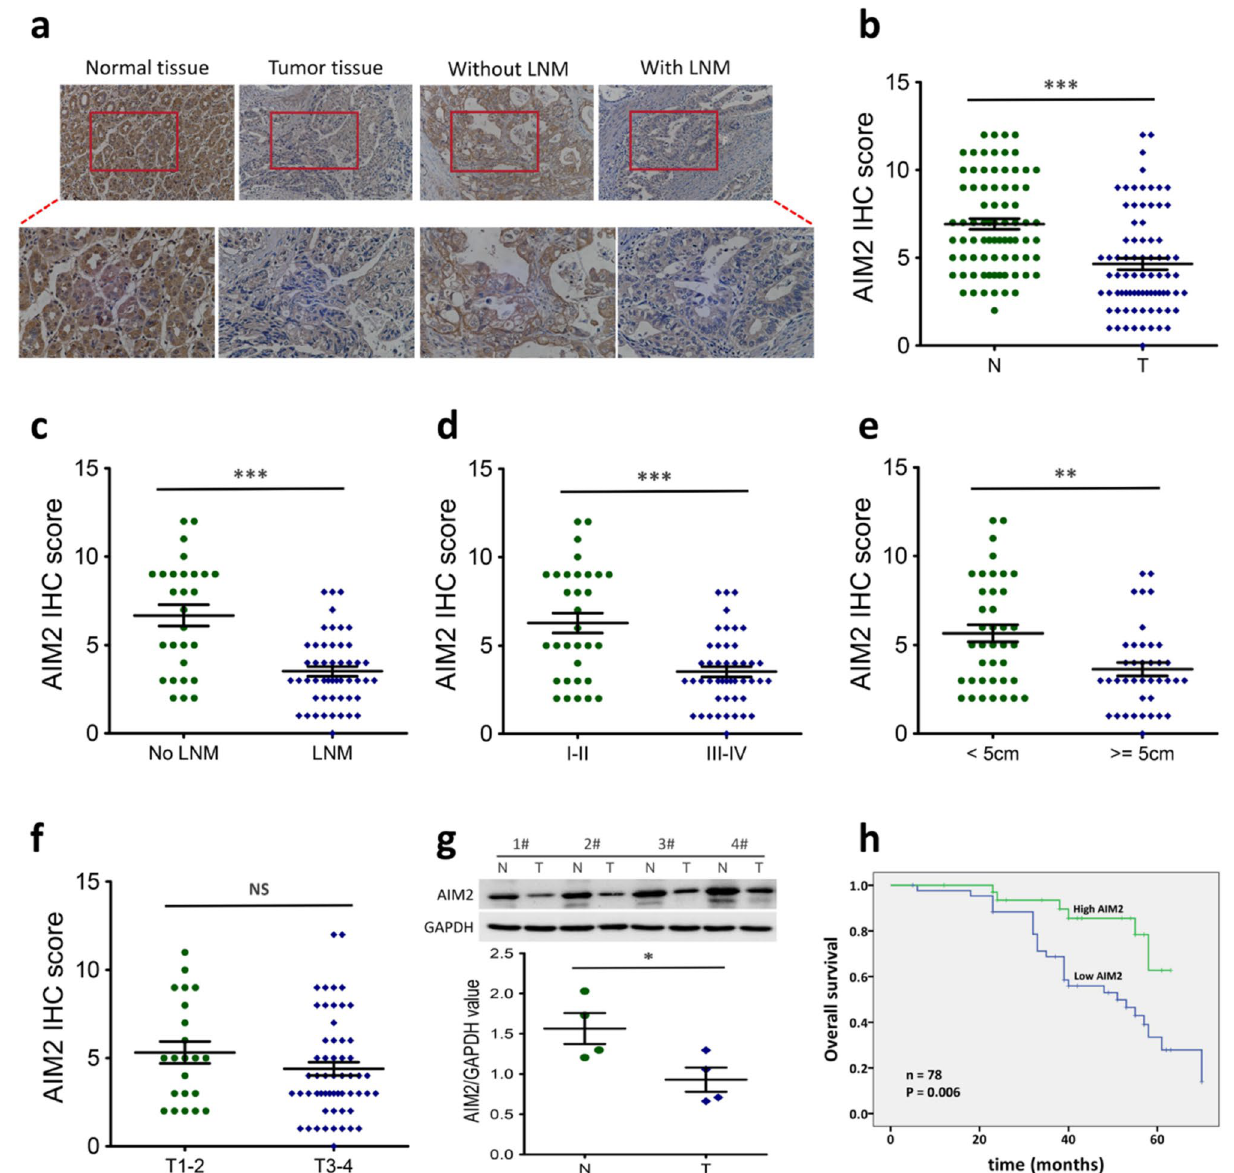
Figure 1. AIM2 is down-regulated in clinical GC tissues. (a ) IHC staining of AIM2 in representative carcinoma and the surrounding tissues of GC. ( b ) Scatter plot analysis of AIM2 levels in 78 cases of GC tissue samples (T) and matched normal tissues (N). ( c ) Scatter plot analysis of AIM2 levels in GC tissues with (n = 50) or without LNM (n = 28). ( d ) Scatter plot analysis of AIM2 levels in GC tissues with TNM stage I–II (n = 32) or stage III–IV (n = 46). ( e ) Scatter plot analysis of AIM2 levels in GC tissues with tumor size < 5 cm (n = 39) or ≥ 5 cm (n = 39). ( f ) Scatter plot analysis of AIM2 levels in GC tissues with depth of invasion T1–2 (n = 22) or T3–4 (n = 56). ( g ) Immunoblotting for AIM2 protein in four randomly selected pairs of GC tumors (T) and their surrounding tissues (N) are presented (top). GAPDH as a loading control. Scatter plot analysis of AIM2/GAPDH values in GC tissues (bottom) The proteins were quantified using the ImageJ software (version: 1.4.3). ( h ) Kaplan–Meier survival curve of GC patients with low or high AIM2 expression. NS, nonsignificant; * P < 0.05; ** P < 0.01; *** P < 0.001. The original Western blots are included in the Supplementary Fig.